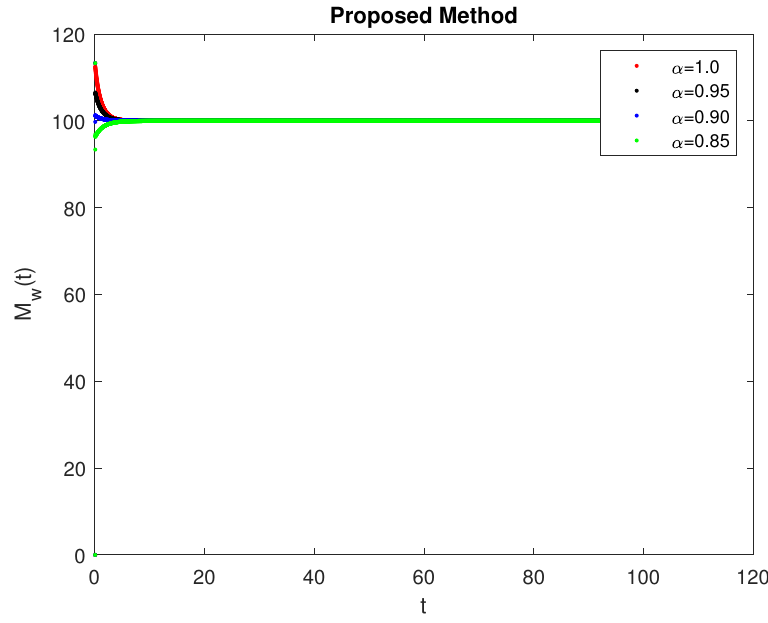
ated at distinct values of parameters α and τ by using descritization and Lagrange’s two step numerical scheme. We analyzed the model with three different kernels namely power law, exponential decay and Mittag-Leffler. Additionally, the corresponding graphical representation of the magnetization components ( M were obtained with respect to time t